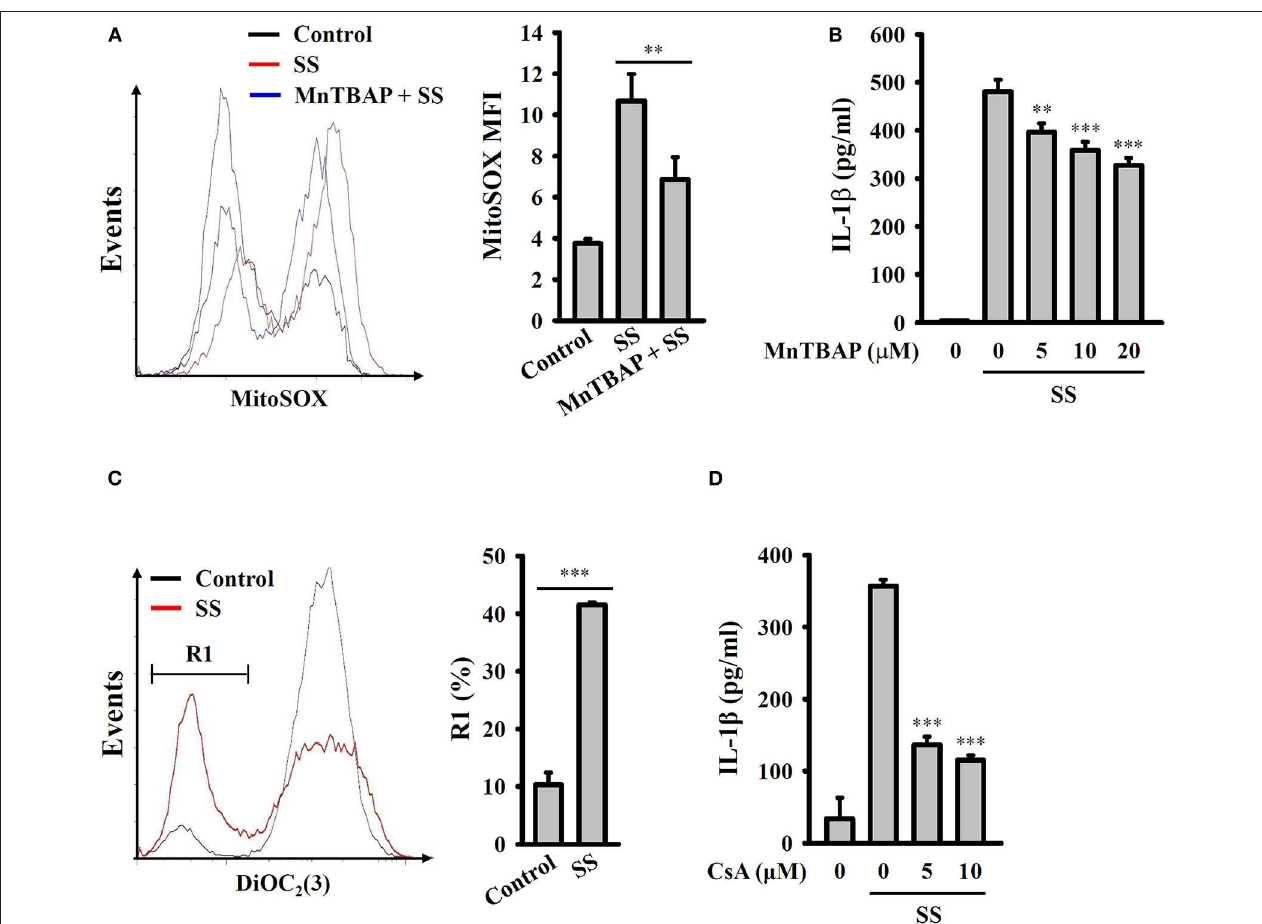
FIGURE 5 | S. sonnei activates the NLRP3 inflammasome through mitochondrial damage. (A) J774A.1 macrophages were primed with 1 µ g/ml LPS for 4h and then treated with 20 µ M MnTBAP for 0.5h. The cells were then infected with 50 MOI S. sonnei for an additional 20h. The levels of mitochondrial ROS were measured by MitoSOX staining and flow cytometry. (B) J774A.1 macrophages were primed with 1 µ g/ml LPS for 4h and then treated with MnTBAP for 0.5h. The cells were then infected with 50 MOI S. sonnei for an additional 20h. The levels of IL-1 β in the supernatants were measured by ELISA. (C) J774A.1 macrophages were primed with 1 µ g/ml LPS for 4h and then infected with 50 MOI S. sonnei for an additional 20h. The mitochondrial membrane potential was measured by DiOC 2 (3) staining and flow cytometry. (D) J774A.1 macrophages were primed with 1 µ g/ml LPS for 4h and then treated with cyclosporine A for 0.5h. The cells were then infected with